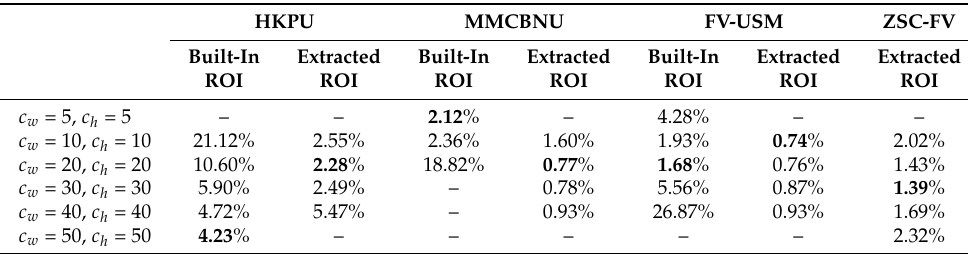
Table 2. Equal error rates (EER) obtained by using different margin parameters on four finger vein